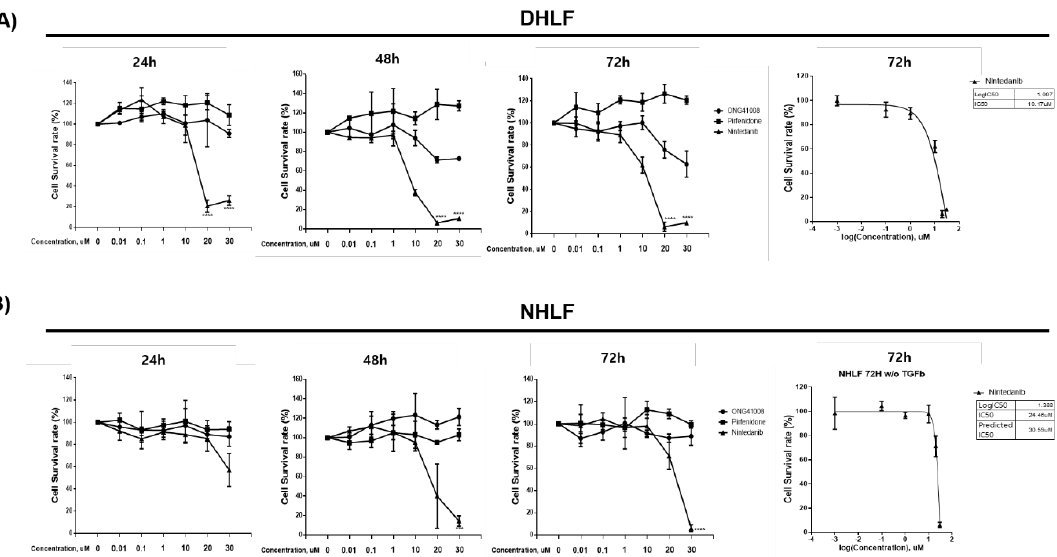
Figure 1. Comparison of the survival rate of DHLFs and NHLFs treated with ONG41008, nintedanib, or pirfenidone. ( A ) and ( B ) DHLFs and NHLFs were stimulated with various concentrations (up to 30 μ M) of the indicated drugs for 24, 48, and 72 h. The cell survival rate was measured using a CCK-8 assay. The IC 50 value of nintedanib was calculated with a sigmoidal, four-parameter logistic in GraphPad Prism, version 7.00. At least three independent measurements were conducted. Standard deviations are denoted by the bar scales.